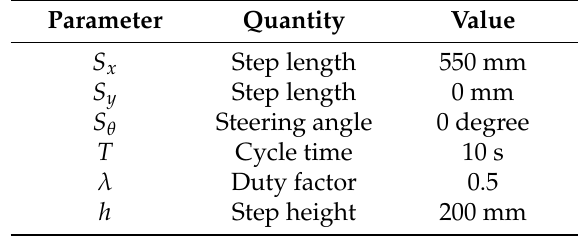
Table 2. Walking parameters.